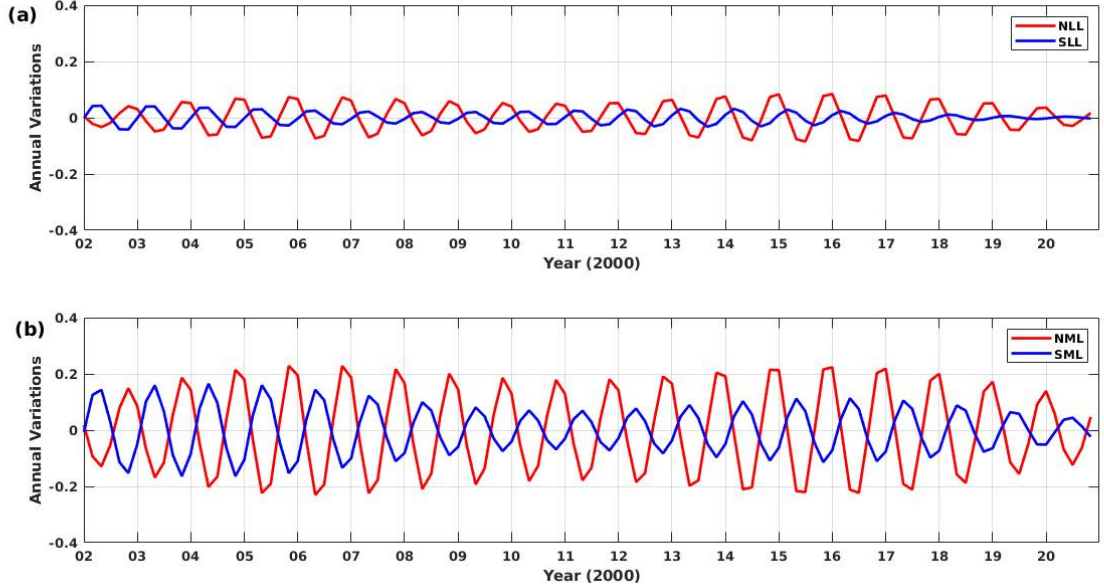
Figure 2. ( a ) Annual variations of mean O/N 2 ratio in both hemispheres for low-latitudes. ( b ) Annual variations of monthly mean O/N 2 ratio in both hemispheres for mid-latitudes.